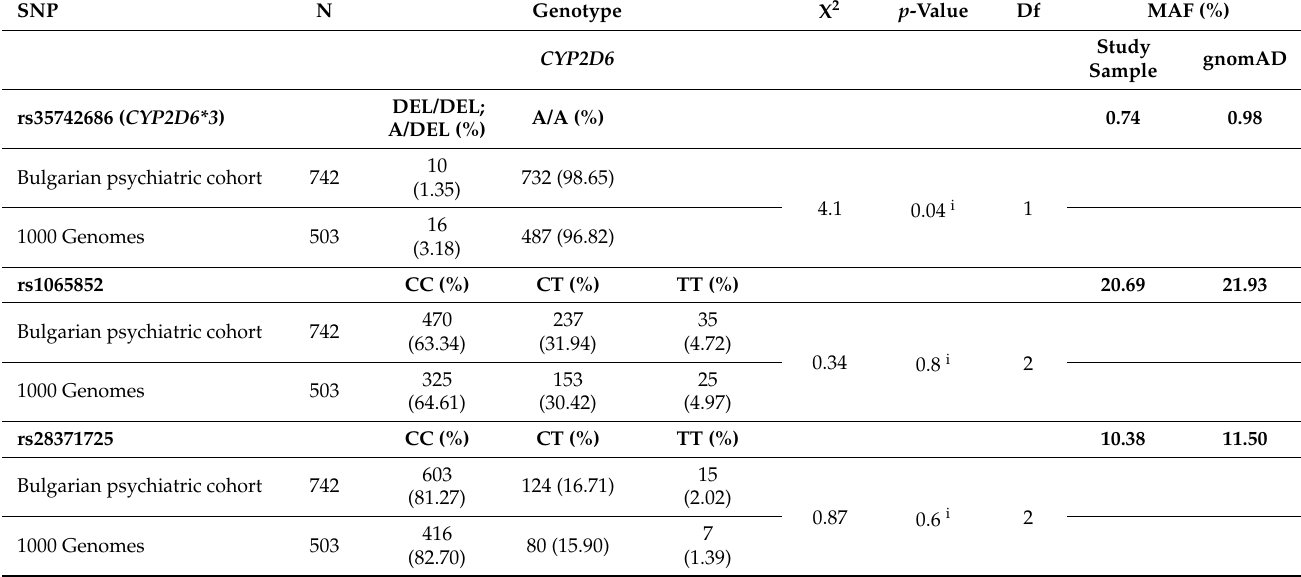
Table 3. Haplotype and diplotype frequencies of CYP2D6